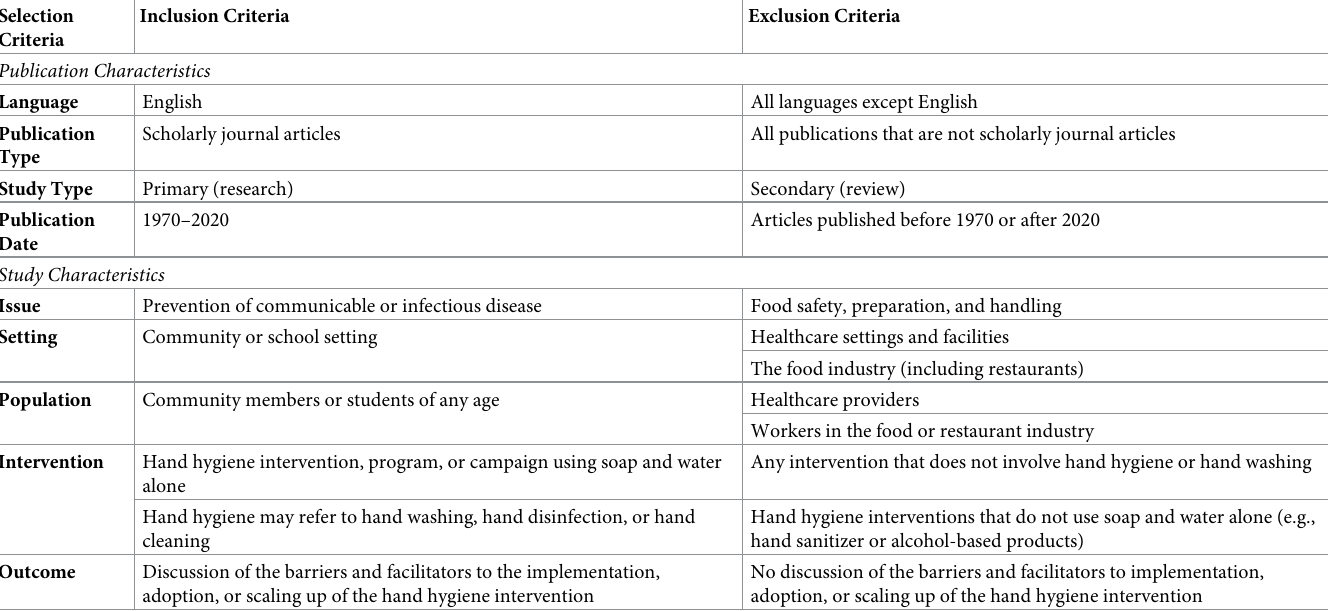
Table 1. Selection inclusion and exclusion criteria for the preliminary analyses of title and abstract screening and full-text